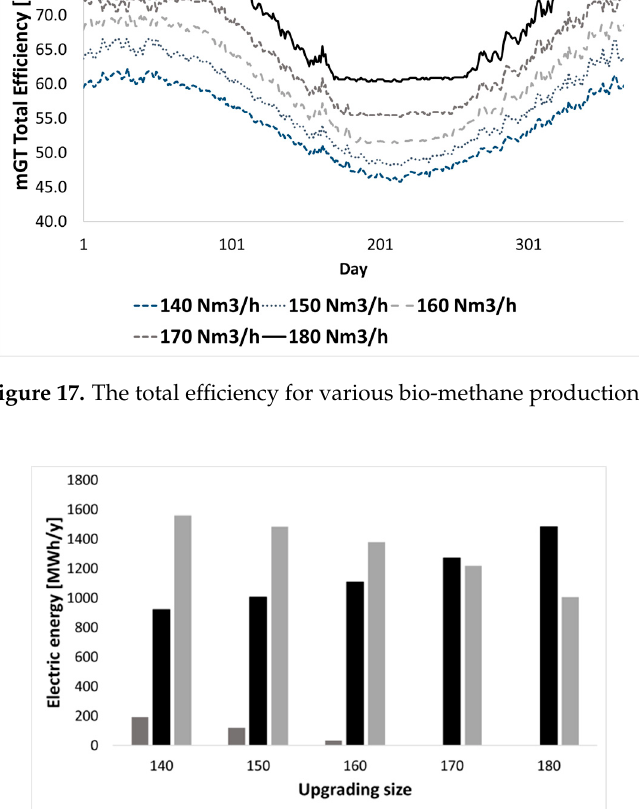
Figure 18. Sold, bought and self-consumed energy as a function of the upgrading size.